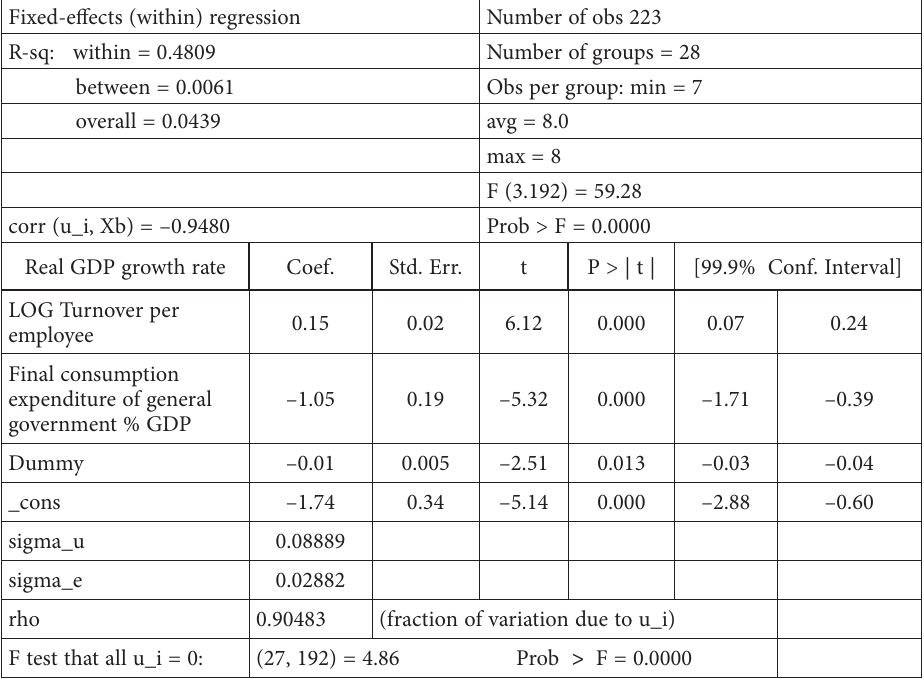
Table 3. Multiple regression using fixed effect model (source: authors’ calculations) Fixed-effects (within)